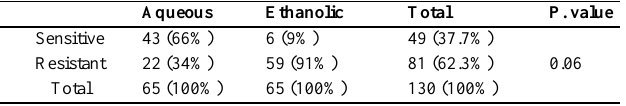
Table 3: Antimicrobial effect of L. Sativum against the total number of isolates (n=65)